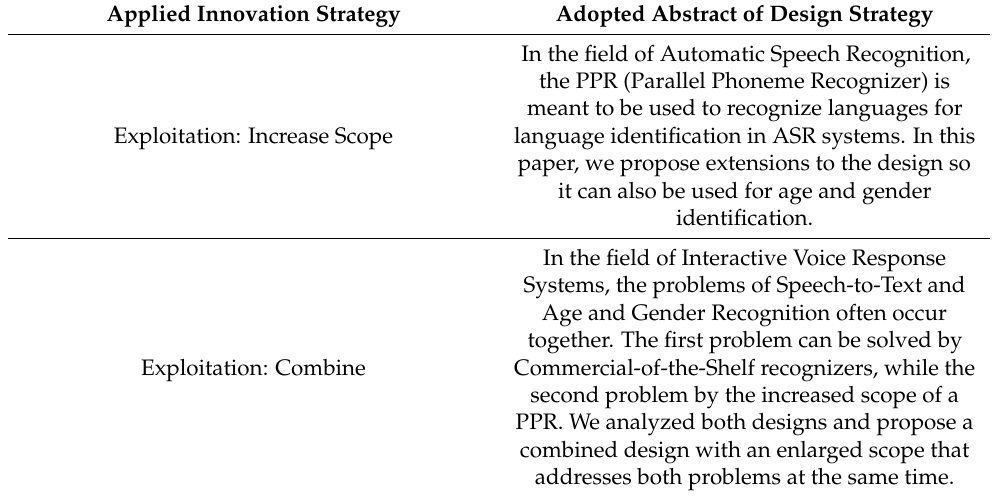
Table 4. Adjusted abstracts for the chosen IISF Strategies (Figure